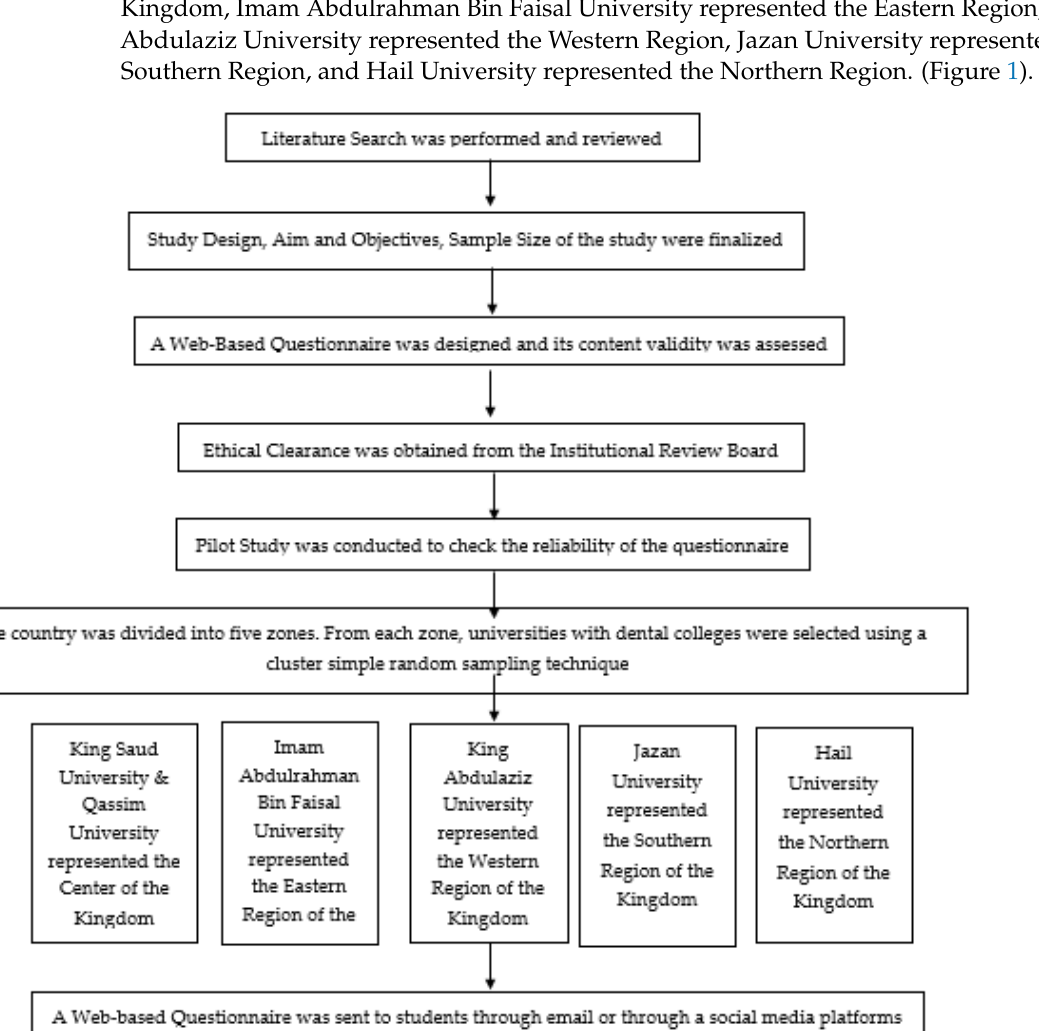
Figure 1. Flow chart for methodology.